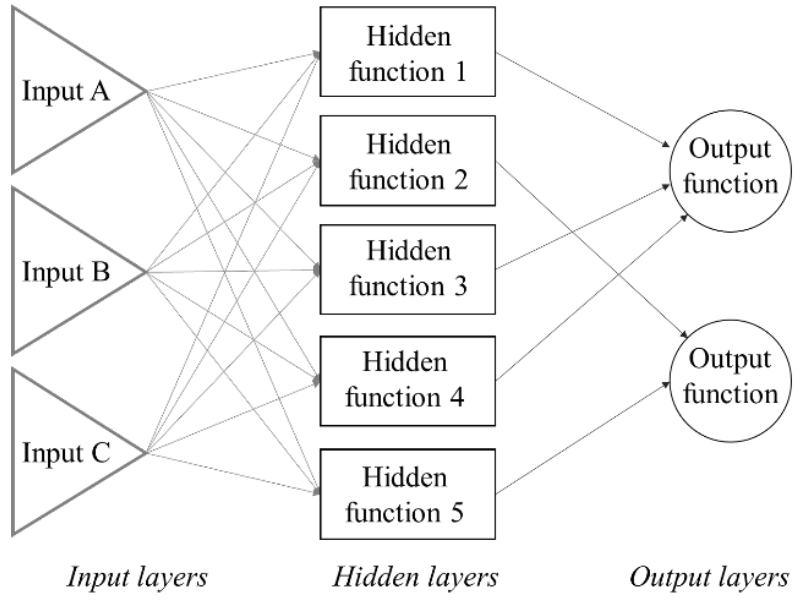
Figure 4. Fundamental schematic of neural network.